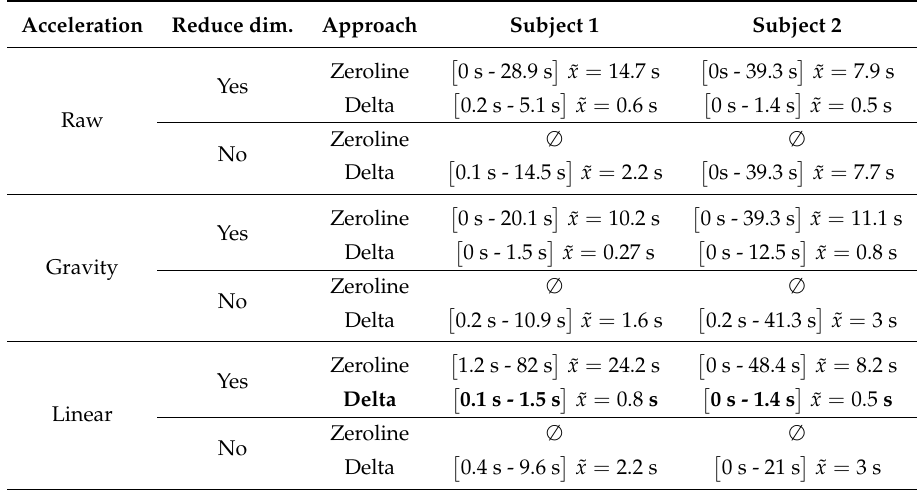
Table 3. Results for matching activities of daily living. For each case we report min and max distance to activities and median distance. The bold values show the best results.